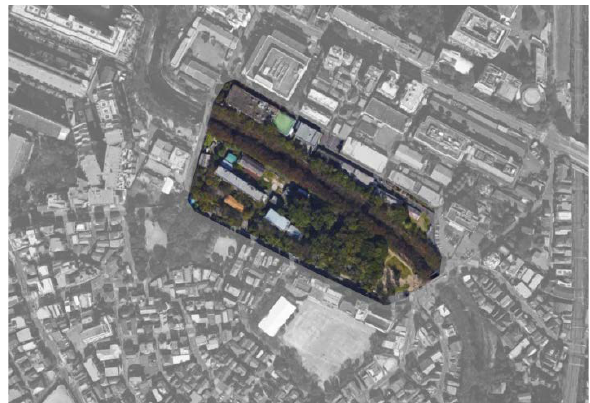
Figure 2: Plan of the Kaga park area.